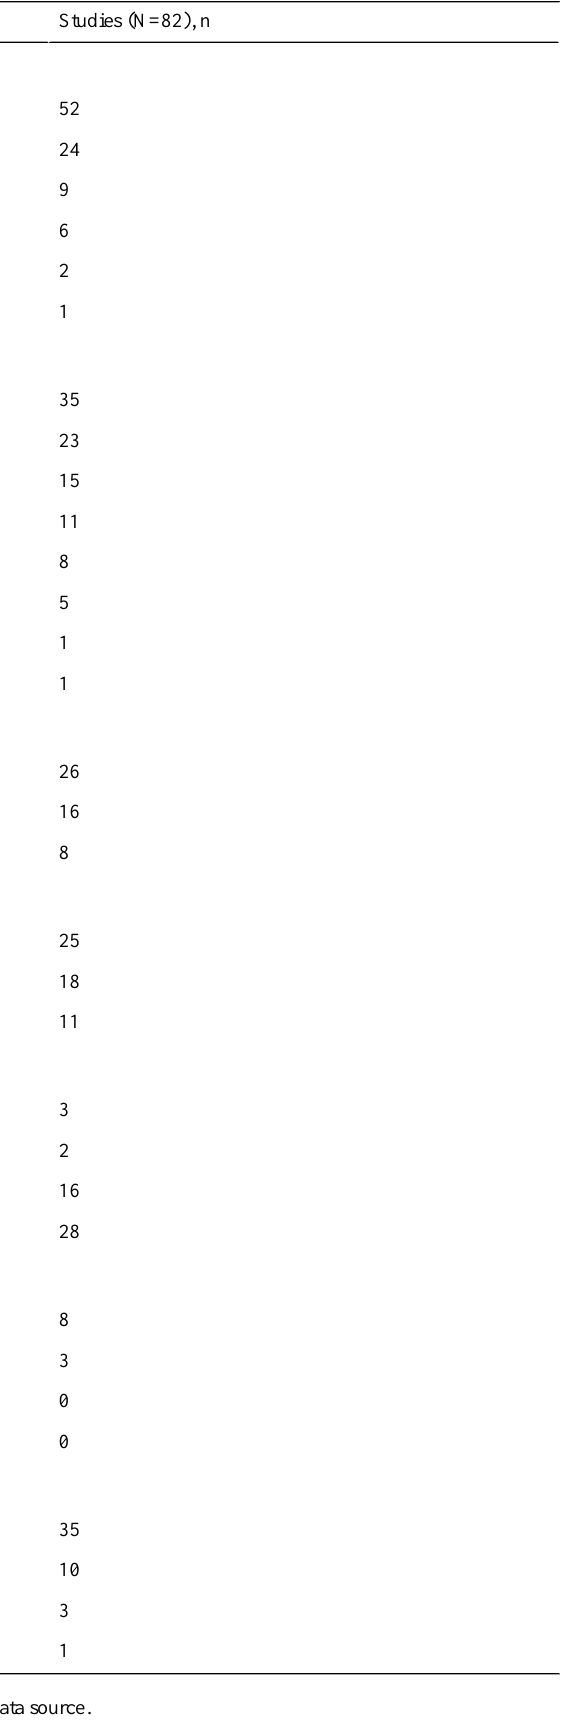
Table 4. Features of data sets used for development and validation of artificial intelligence